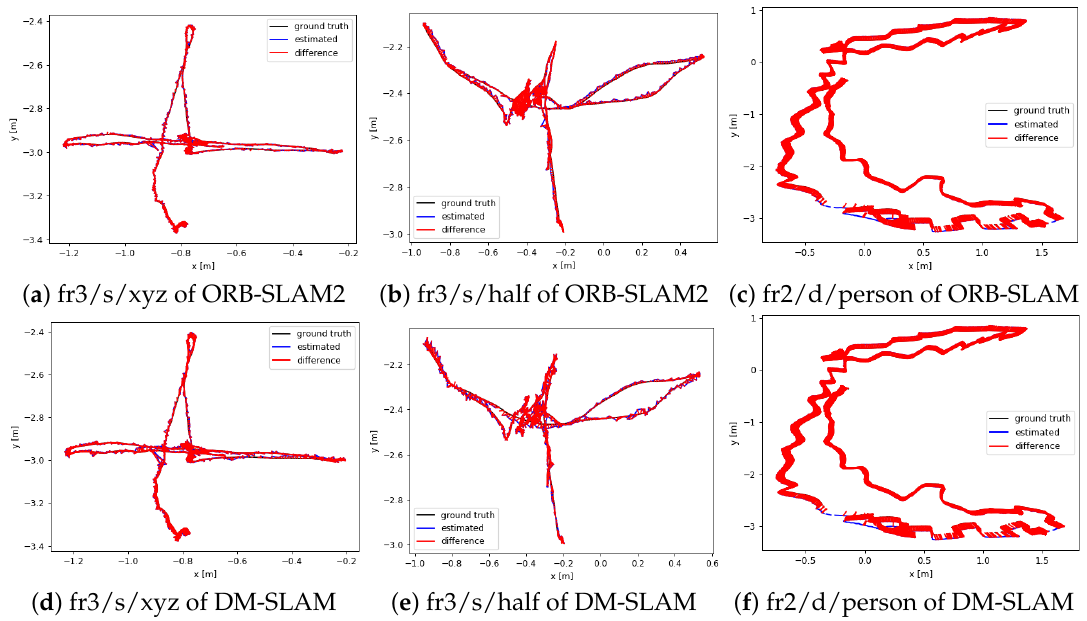
Figure 9. Plots of the ATE [m] for low-dynamic scenes : fr3/s/xyz , fr3/s/half , fr2/d/person ; ( a – c ) the experiments performed with ORB-SLAM2; ( d – f ) the experiments performed with DM-SLAM.